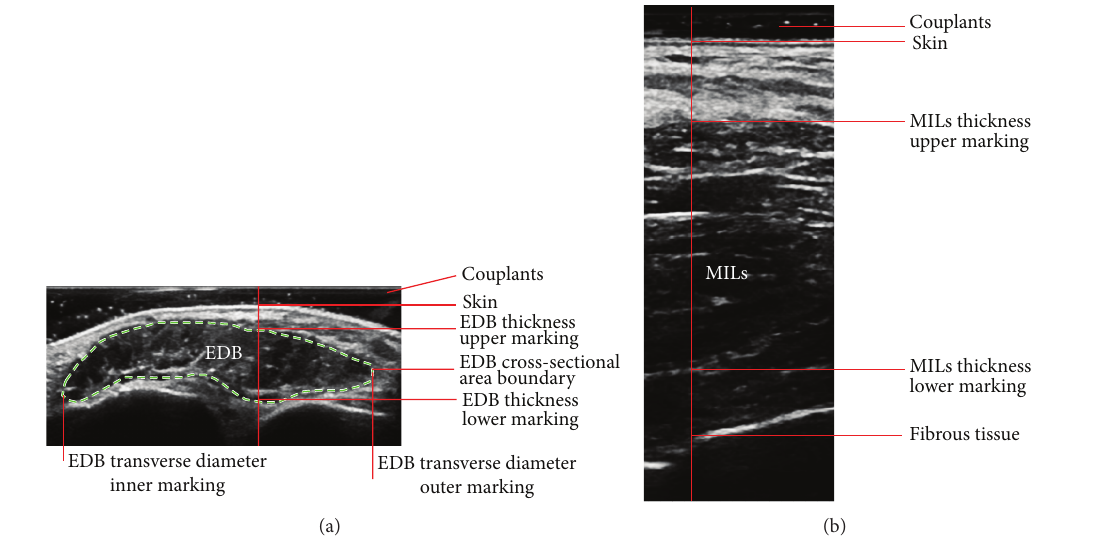
Figure 1: Ultrasonographic images of the extensor digitorum brevis muscle (EDB) and the muscles of the first interstitium (MILs). (a) A representative ultrasonic image of EDB, along with the enthesis (indicating lines with annotations) and boundary (dashed line) of the measured transverse diameter, thickness, and cross-sectional area. (b) A representative ultrasonic image of MILs and the enthesis (indicating lines with annotations) of the measured